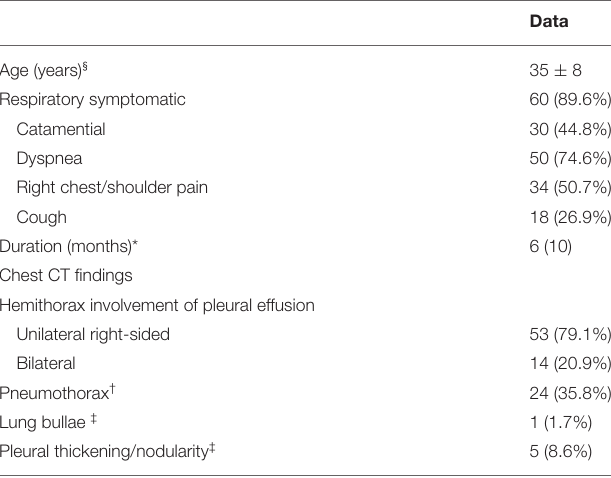
TABLE 1 | Demographics and clinical characteristics of patients with endometriosis-related pleural effusion ( n = 67).